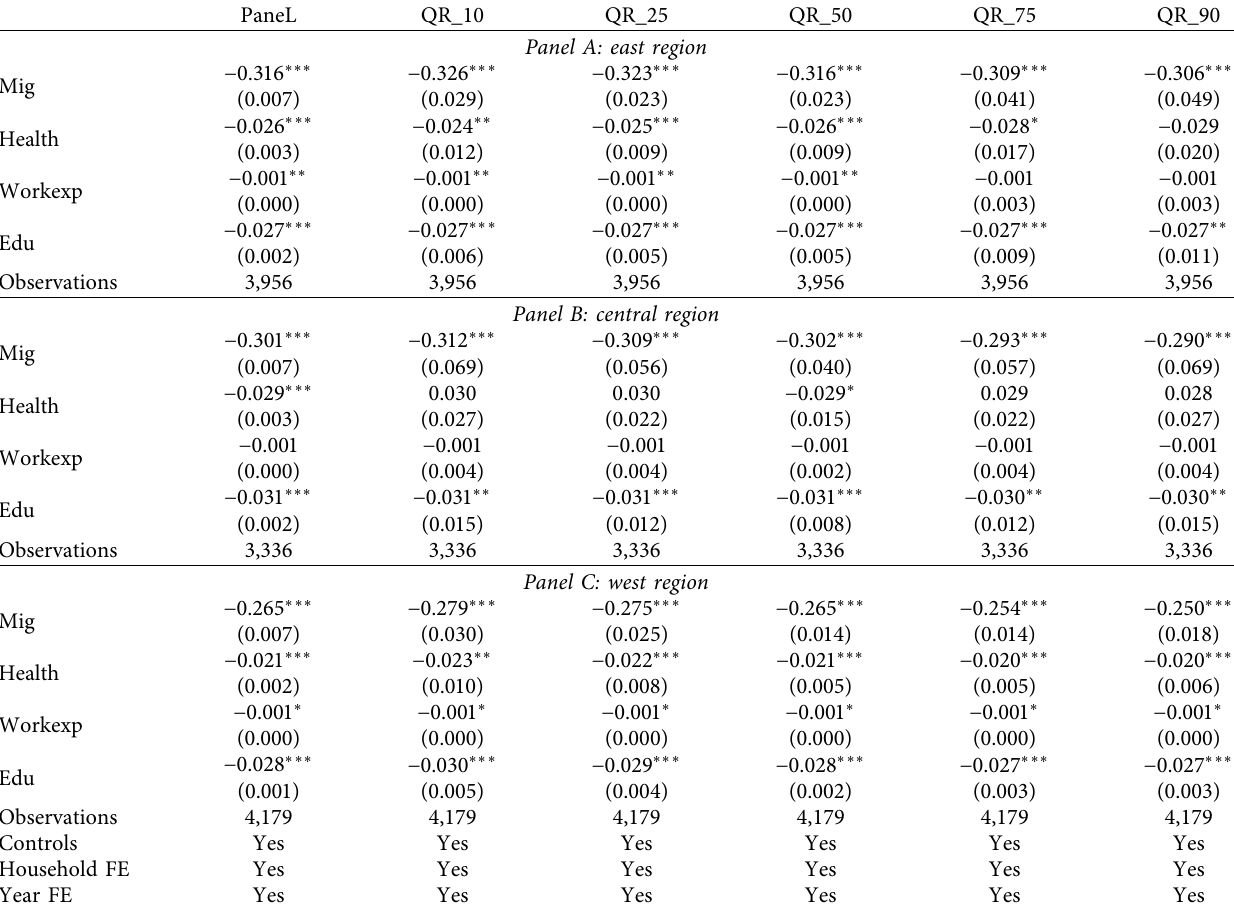
Table 3: Impact of human capital on vulnerability to relative poverty by